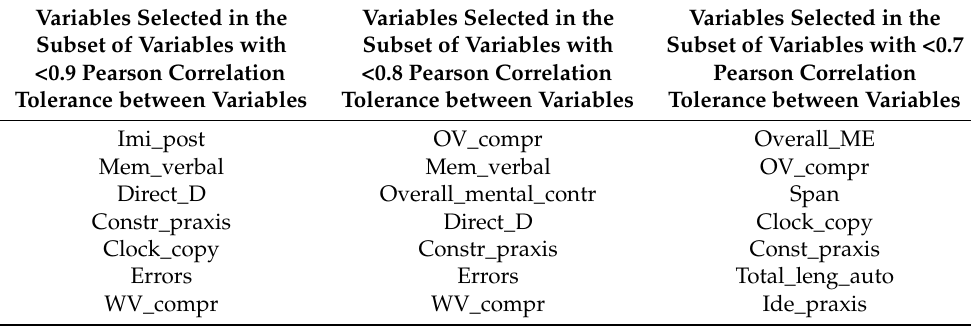
Table 6. Automatic selection of variables important for EF prediction. Variables Selected in the Subset of Variables